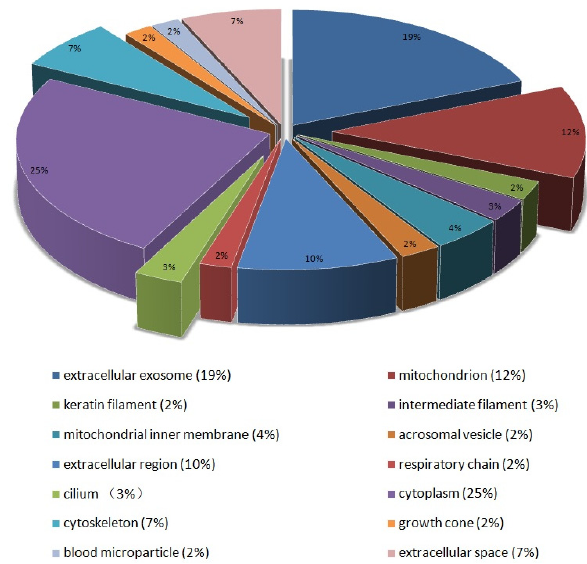
Figure 3. Subcellular classification of DEPs.